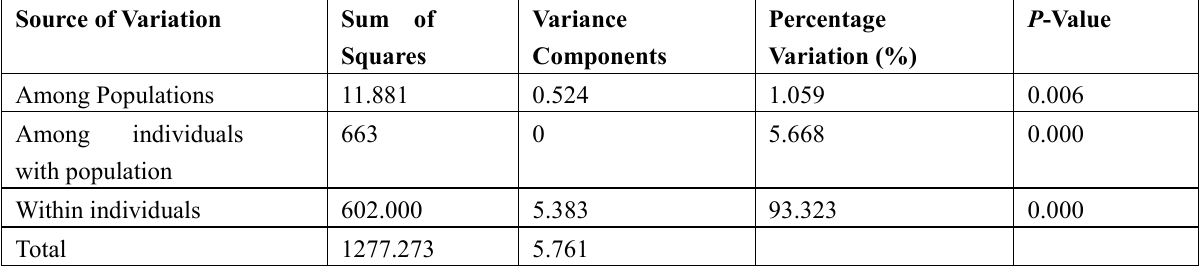
Table 4. Analysis of molecular variance (AMOVA) of 15 microsatellite loci in the wild and hatchery populations of Atrina pectinata